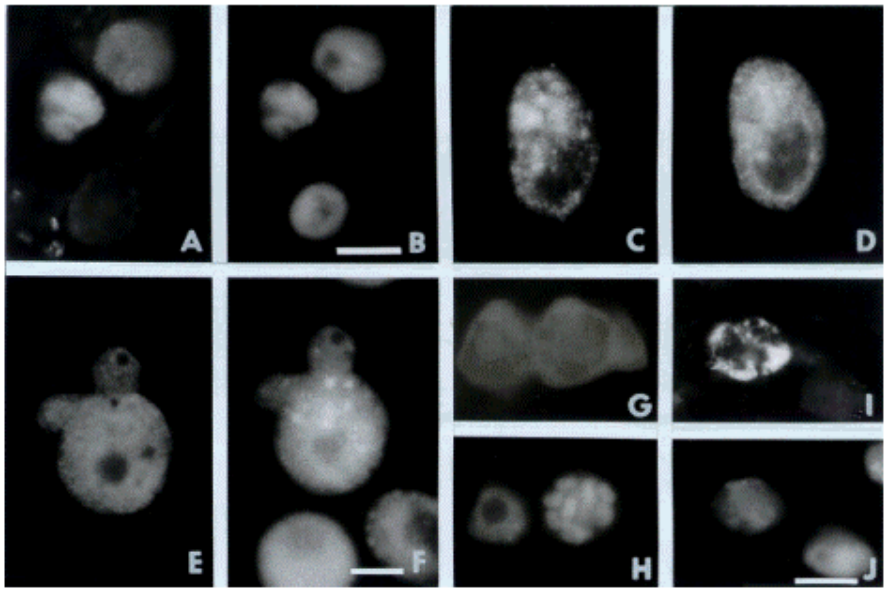
Fig. 1. Immunofluorescence in situ detection of DNA double strands breaks in cells of V.